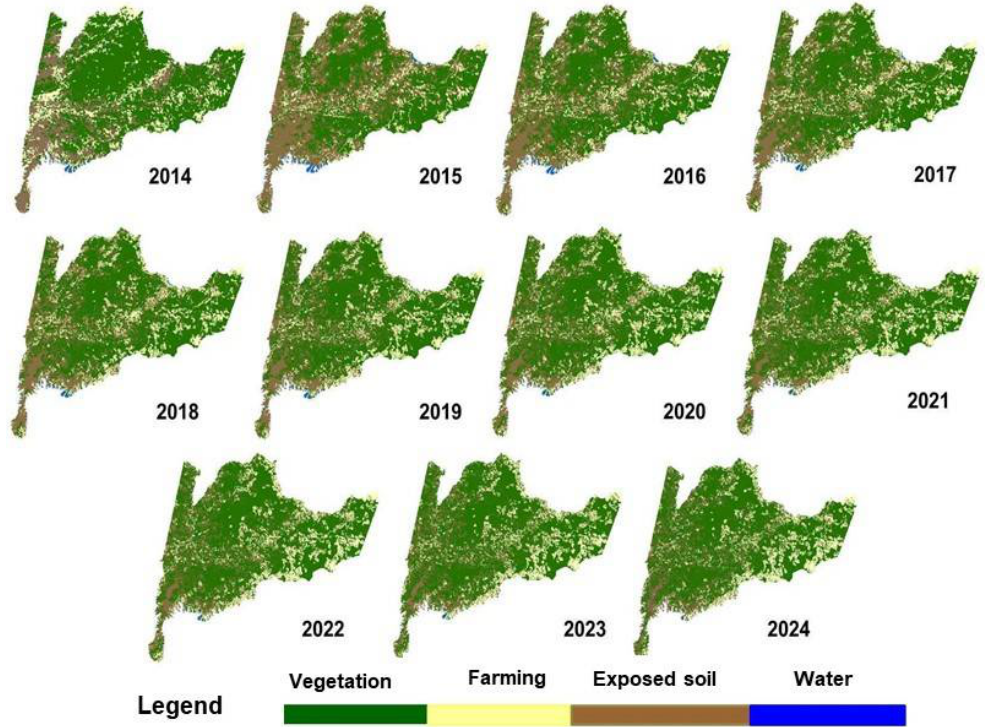
Figure 6. Result of the annual simulation between 2014 and 2024 for the municipality of Floresta— PE.